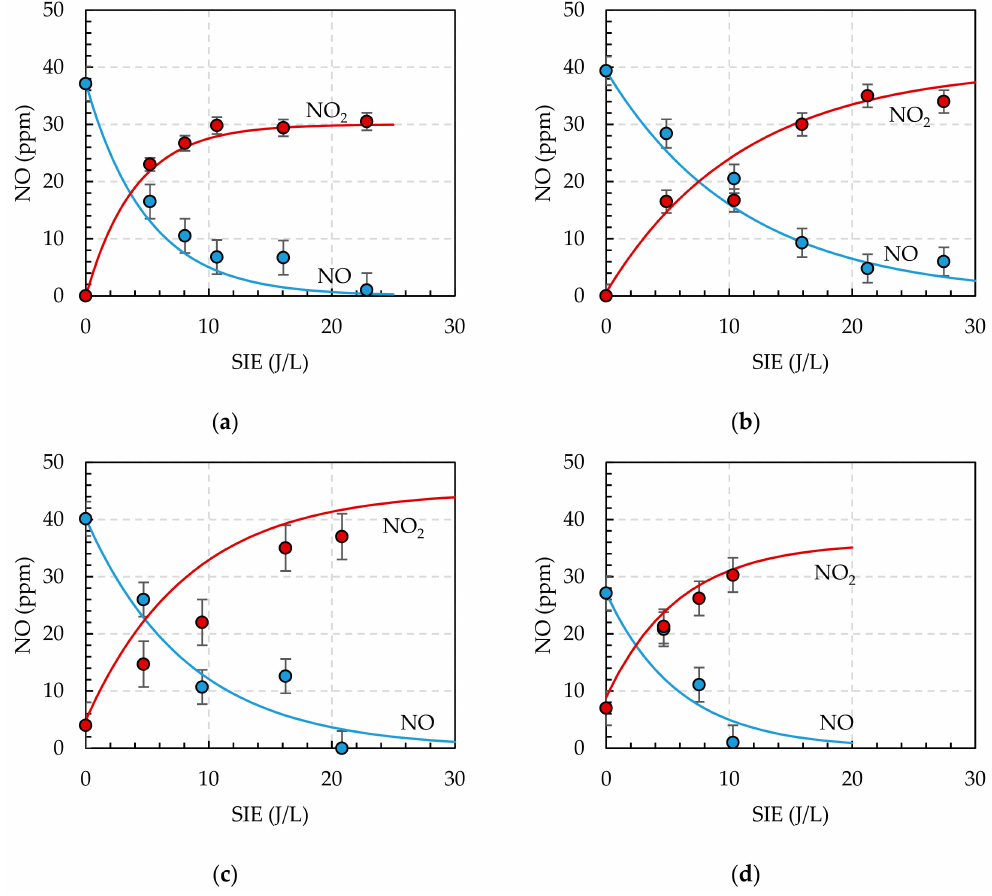
Figure 4. The direct plasma oxidation of nitrogen oxide at ER ( a ) 0.8; ( b ) 1.0; ( c ) 1.2; ( d ) 1.4 value (Lines show the fit of experimental results by exponential function